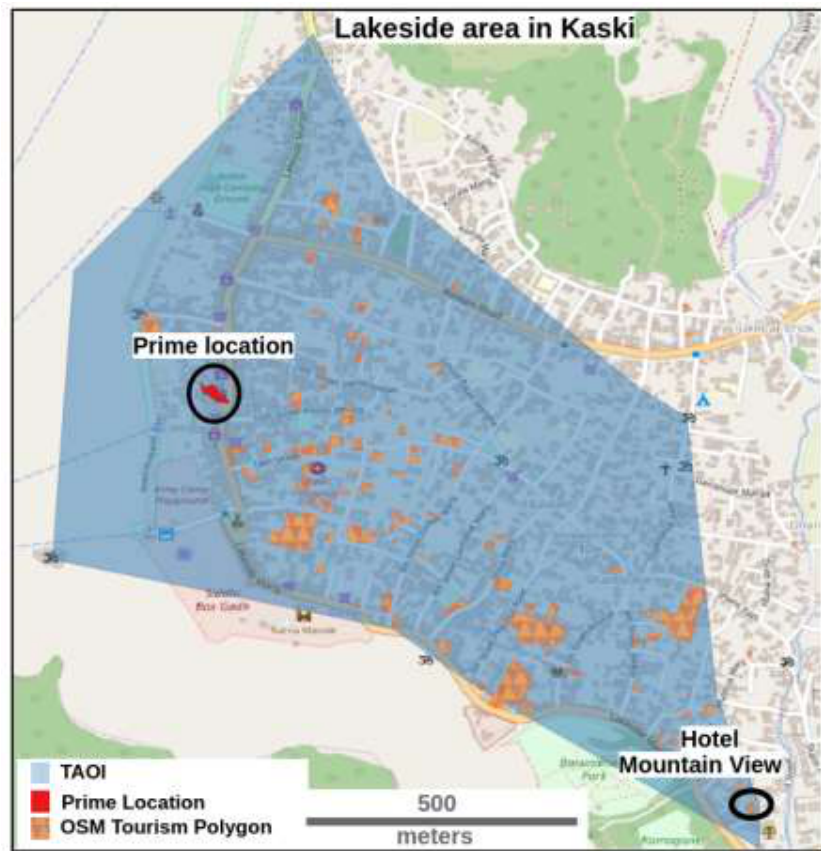
Figure 7. Lakeside Areas as Important TAOI in Kaski with Main Locations (Source: Devkota et al.,